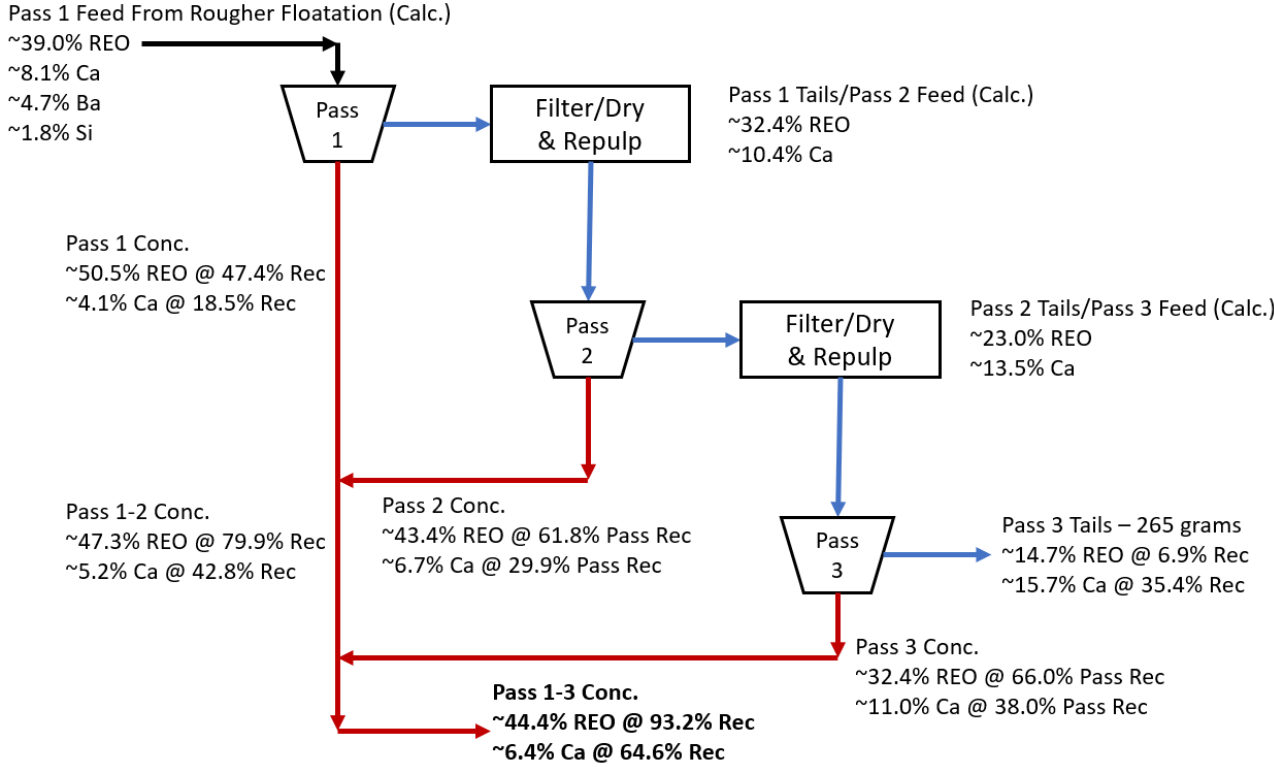
Figure 12. Flowsheet of Williams’ UF Falcon test work on enhanced rougher flotation concentrate. Ca, Ba, and Si grades have been converted from the original reported values of CaO, BaO, and SiO 2 from the source documentation [9].